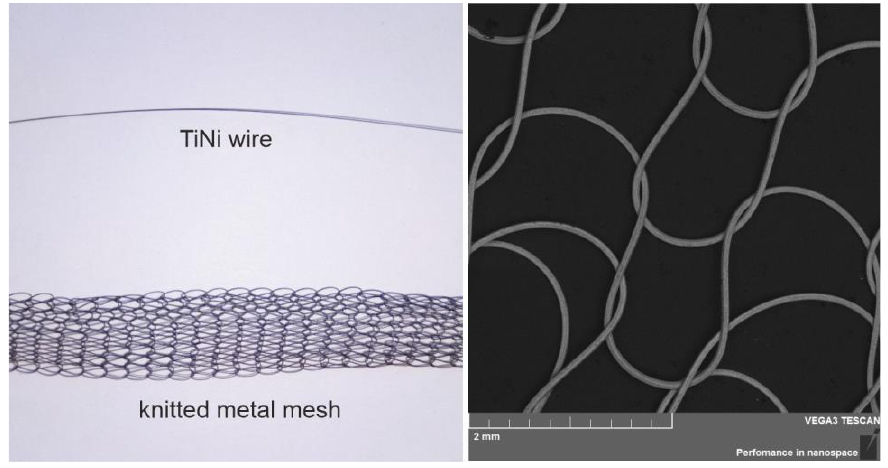
Figure 2. TiNi wire and knitted metal mesh.